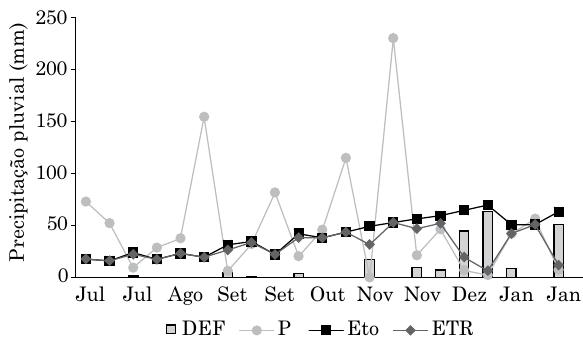
Figura 2. Balanço hídrico da e stação experimental agronômica da Universidade Federal do rio grande do Sul calculado pelo método penman-monteith durante período experimental (2013/2014). DeF: déficit hídrico, P: precipitação pluvial, Eto: evapotranspiração de referência e etr: evapotranspiração